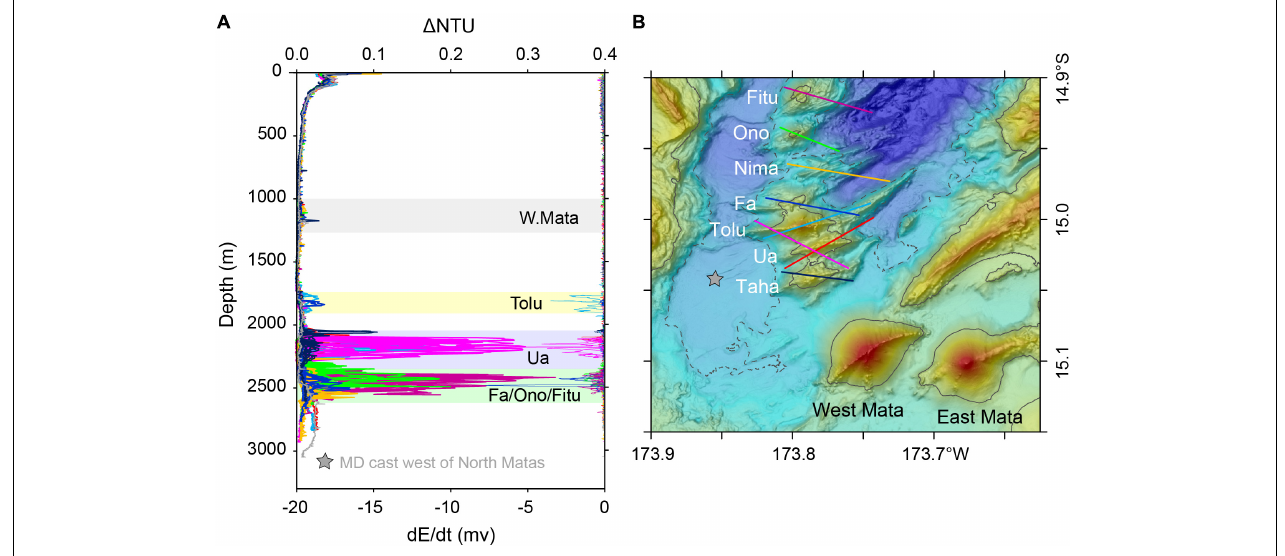
FIGURE 4 | 2010 North Mata hydrothermal plume profiles. (A) (cid:49) NTU (left side, top axis) and dE/dt (right side, bottom axis) profiles from CTD tows over the North Mata volcanos; (B) map of North Mata CTD tow tracklines. Colors of tracklines in (B) correspond to profile line colors in (A) .